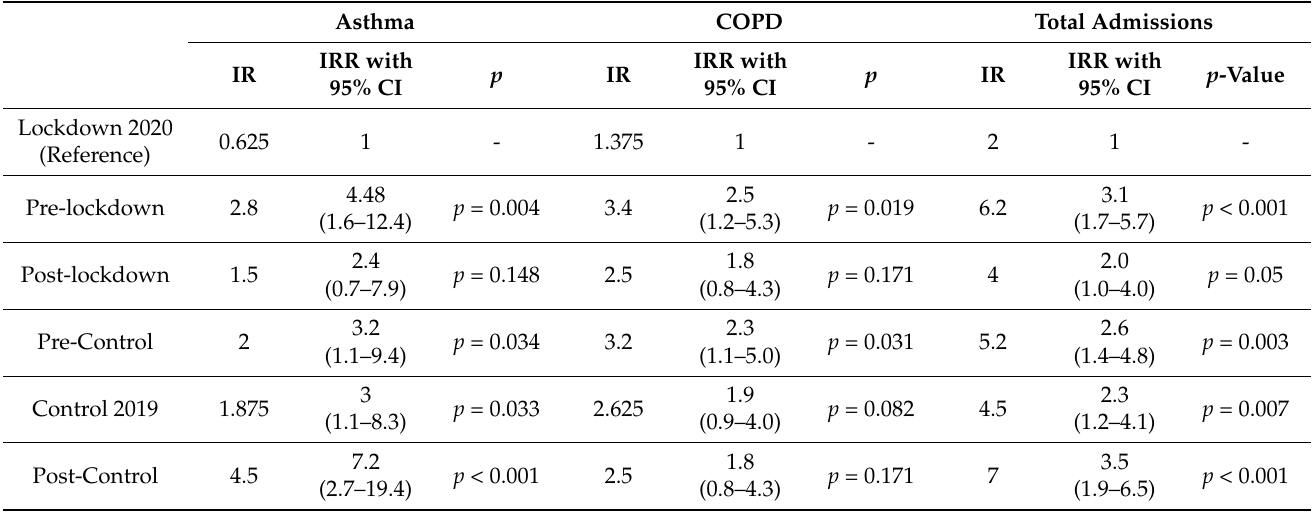
Table 2. Comparisons among incidence rates between lockdown and the different study